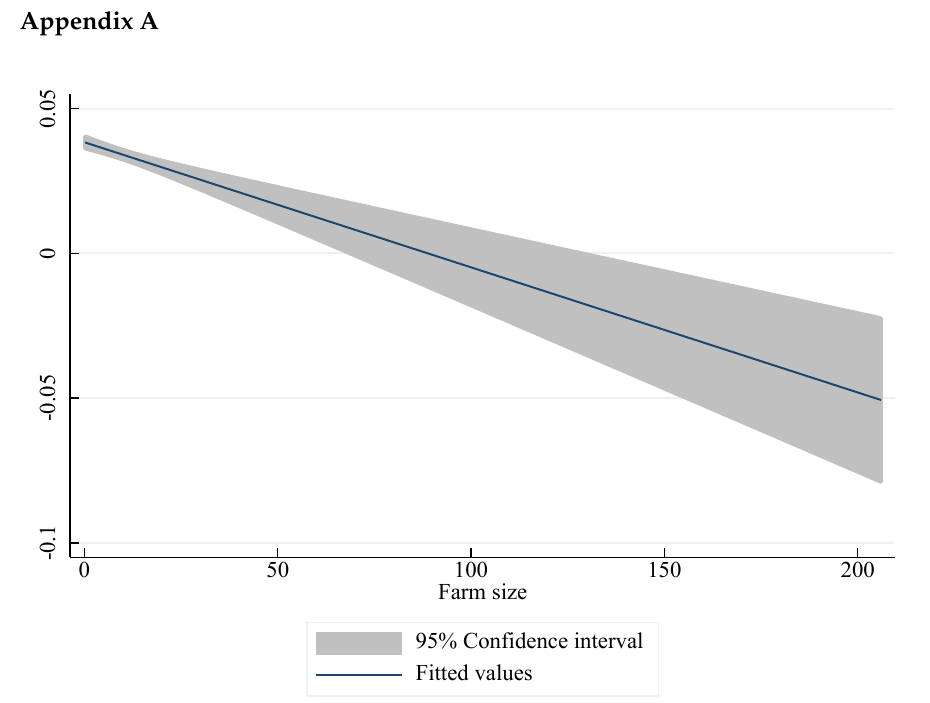
Figure A1. The relationship between farm size and rice harvest loss (fitted line).